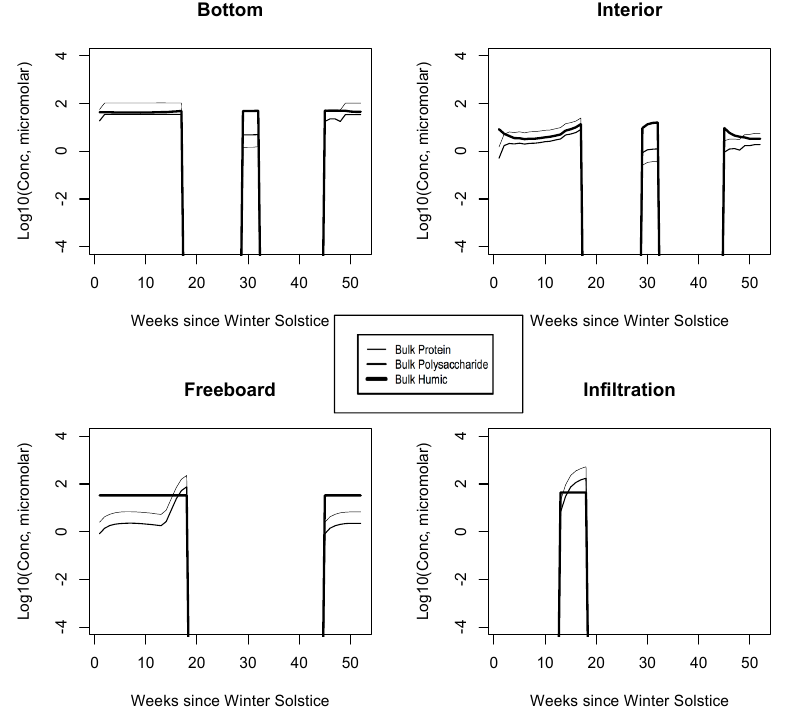
Figure 9. Sea of Okhotsk. Time evolution for bulk organic concentrations from the light-dependent run, for the four habitat levels. Values are base 10 logarithms for carbon in micromolar. Lipid profiles closely follow proteins or polysaccharides and for simplicity are not shown.